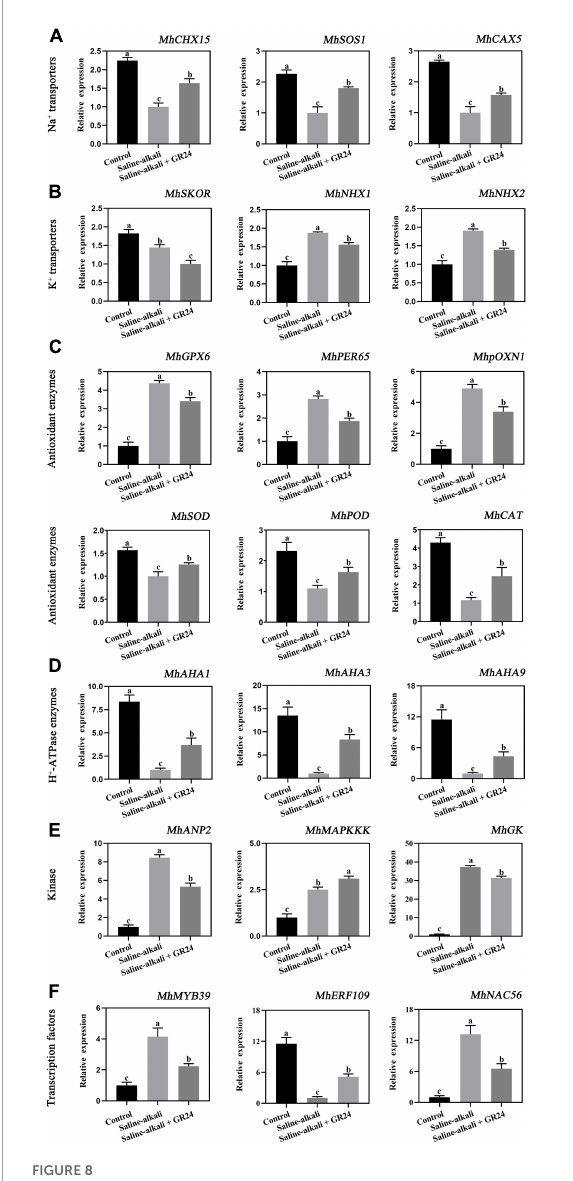
FIGURE8 The expression level of the 21 candidate genes which divided into Na + transporters ( MhCHX15 , MhSOS1 , and MhCAX5 ) (A) , K + transporters ( MhSKOR , MhNHX1 , and MhNHX2 ) (B) , H + -ATPase (AHA) enzyme family genes ( MhAHA1 , MhAHA3 , and MhAHA9 ) (C) , antioxidant enzymes ( MhGPX6 , MhPER65 , MhpoxN1, MhSOD , MhPOD and MhCAT ) (D) , kinase ( MhANP2 , MhMAPKKK , and MhGK ) (E) , and transcription factors ( MhMYB39 , MhERF019 , and MhNAC56 ) (F) . The data represent the mean ± SD of three biological replicates. Different lowercase letters indicate significant differences according to Fisher’s least significant difference ( P <